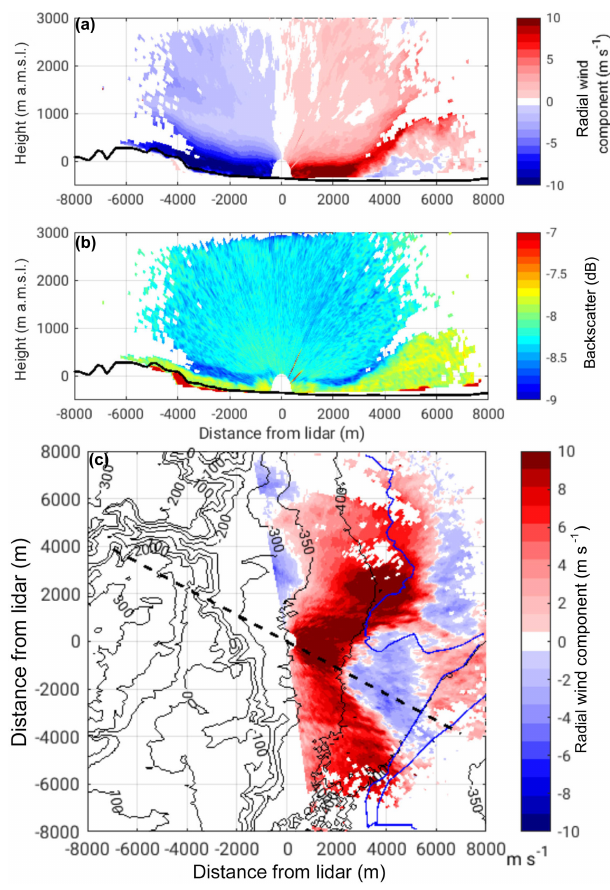
Figure 12. RHI scan at an azimuth angle of 299 ◦ (dashed line in c ) showing radial velocity (a) and backscatter (b) on 16 August 2014, 19:36LT. PPI scan at an elevation angle of 0.2 ◦ , shows radial ve- locity (c) at 19:51LT. In (a) and (c) blue colours indicate a flow towards the lidar and red colours indicate a flow away from the li- dar. The shoreline of the Dead Sea is indicated by a dark blue line in (c)